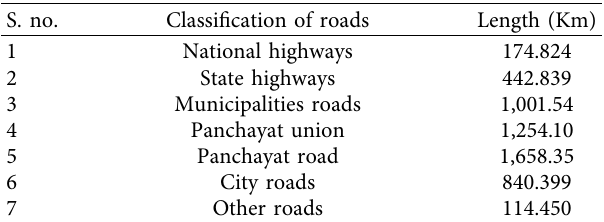
Table 1: Classification of roads and their length in Tirunelveli city. S.